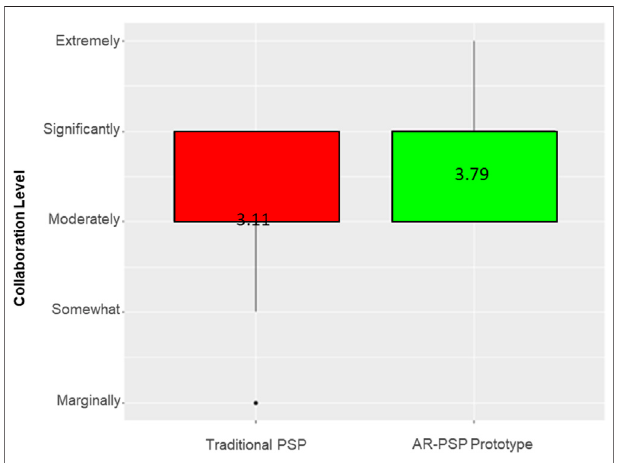
FIGURE 9 | Collaboration — Traditional PSP vs AR-PSP.